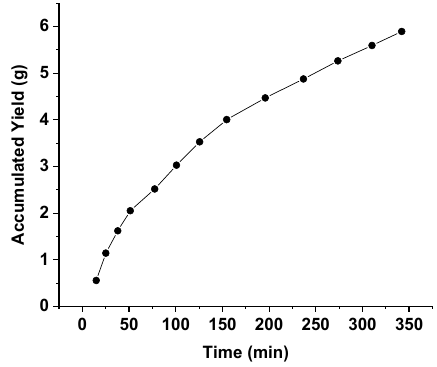
Figure 1. Kinetic curve obtained for the mean accumulated extract mass versus the total extraction time of the propolis sample.